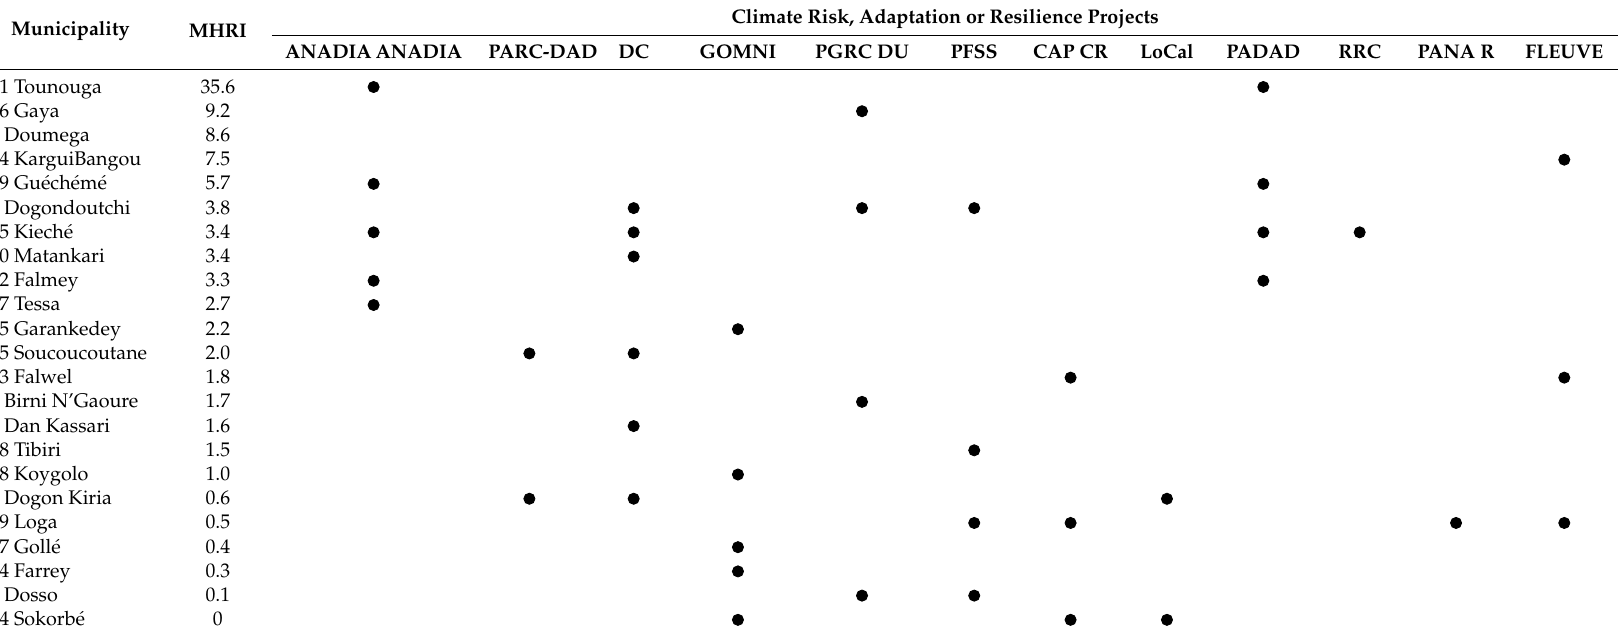
Table 6. Municipalities benefiting from risk, adaptation, or resilience actions according 12 projects and